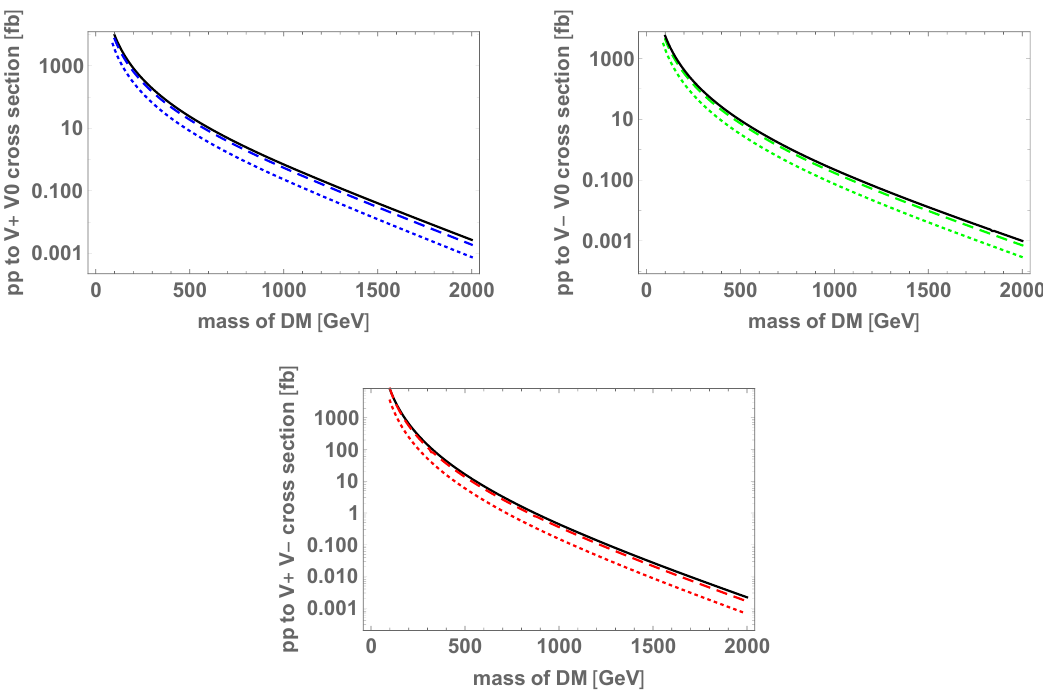
p ~ W s = 13 TeV. (cid:6) and (cid:6) from proton collisions at